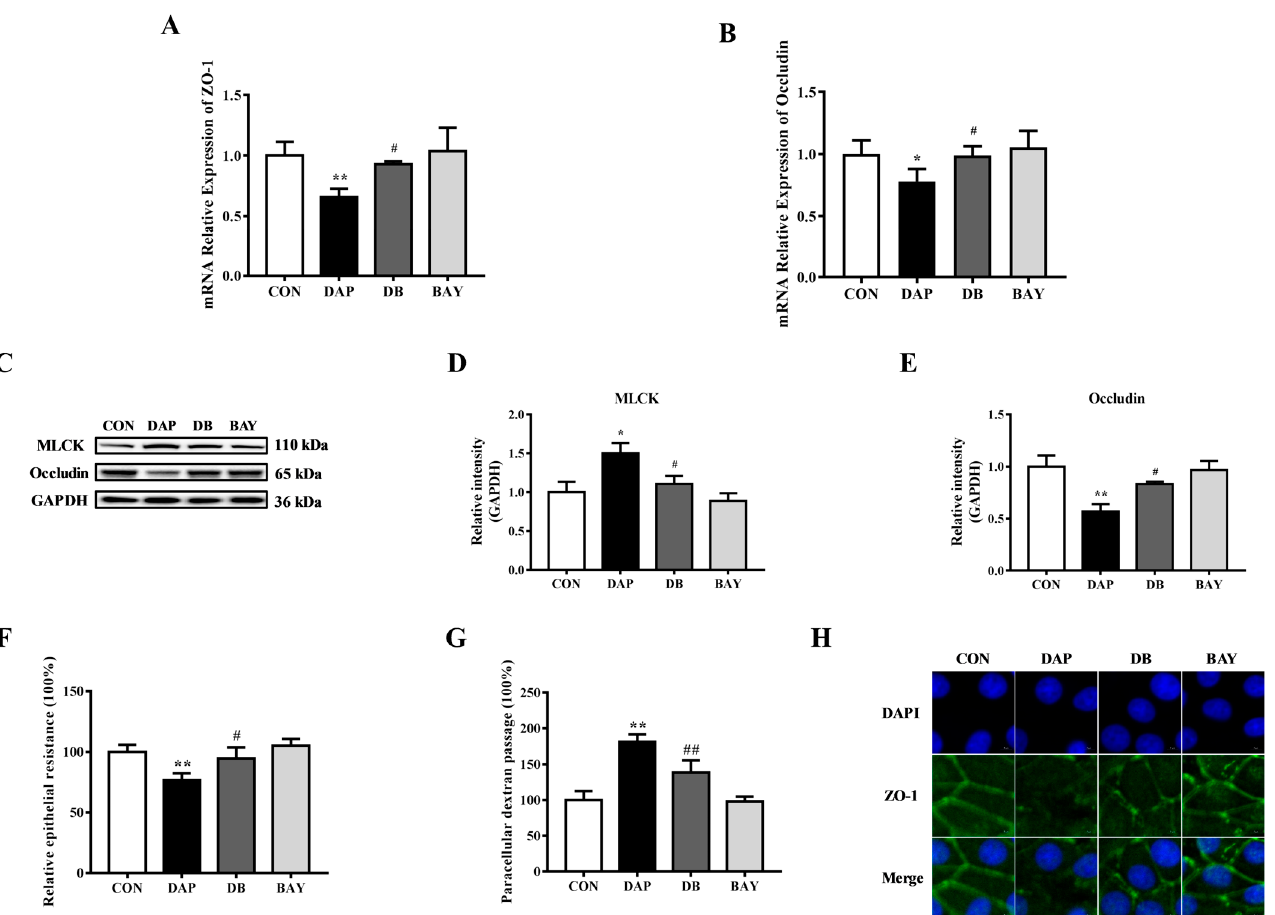
Figure 5. Effects of BAY 11-7085 on the TJ disruption induced by iE-DAP in BMECs. ( A , B ) Gene expression of ZO-1 and Occludin in BMECs treated with 1000 ng/mL iE-DAP for 12 h after 10 µ M BAY 11-7085 pretreatment for 1 h. ( C – E ) WB representative bands and quantitative results of MLCK and Occludin in BMECs treated with iE-DAP after BAY 11-7085 pretreatment. ( F ) Relative epithelial resistance and ( G ) paracellular dextran passage of the BMEC monolayer treated with iE-DAP after BAY 11-7085 pretreatment. ( H ) Immunofluorescence results of ZO-1 in BMECs treated with iE-DAP after BAY 11-7085 pretreatment. In the immunofluorescence results, the scale bar = 5 μ m. Results were presented as the mean ± SEM. * p < 0.05, ** p < 0.01, represent a significant difference compared with the control group. # p < 0.05, ## p < 0.01, represent a significant difference compared with iE-DAP group.